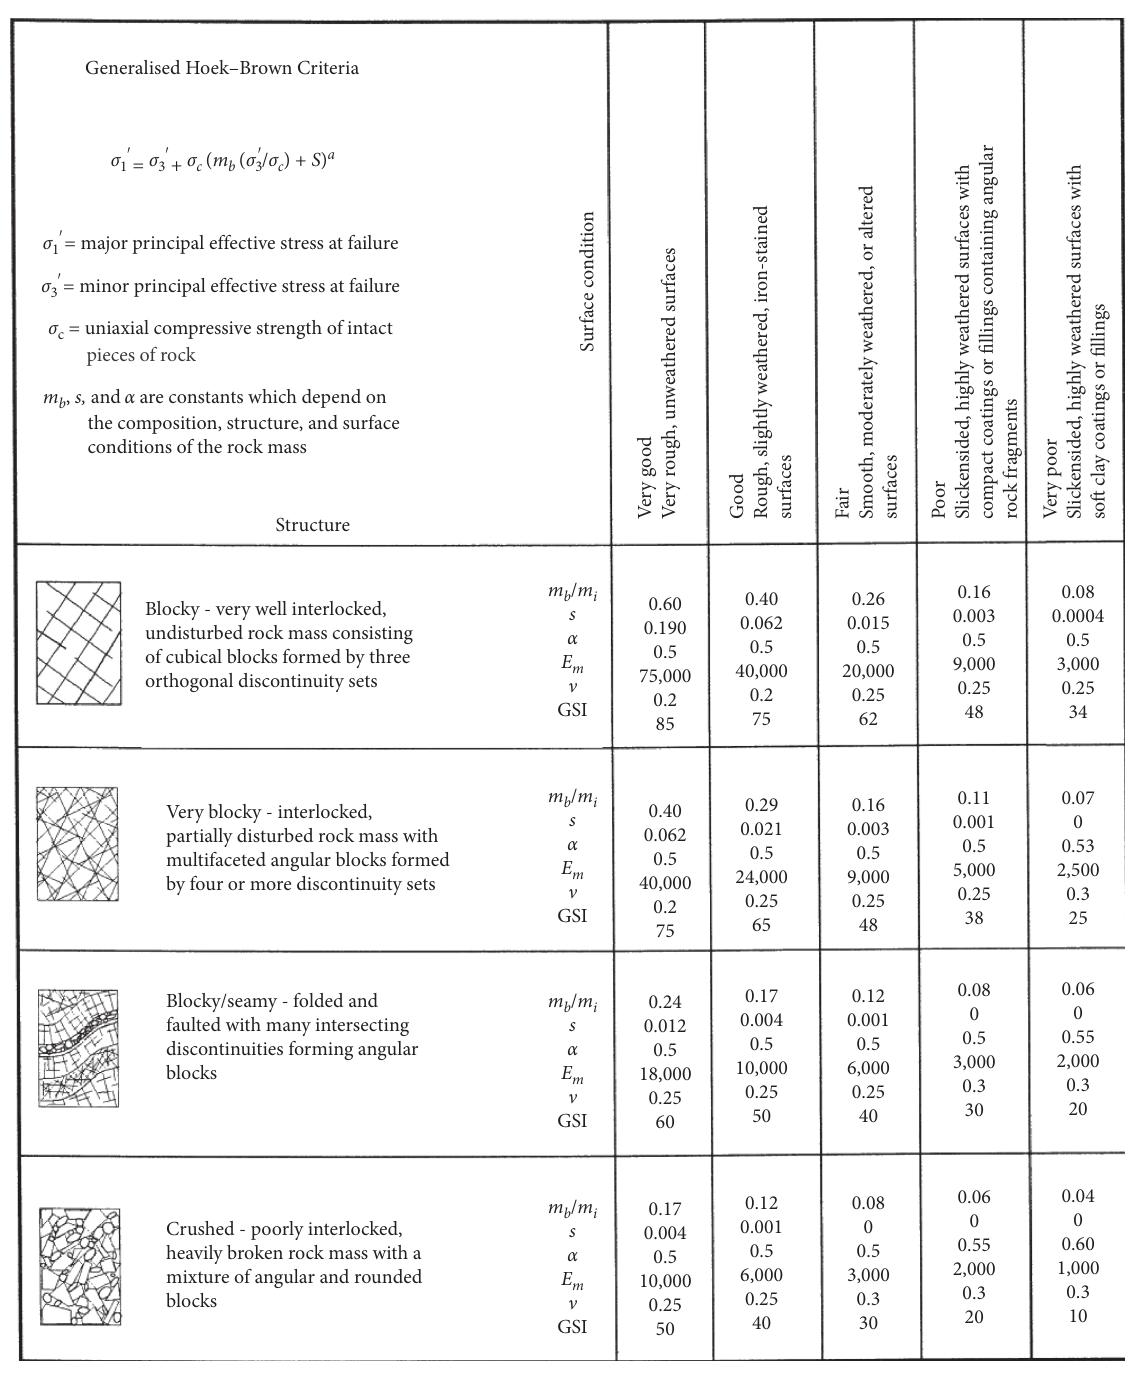
Figure 3: Hoek and Brown failure criterion linkage with the GSI